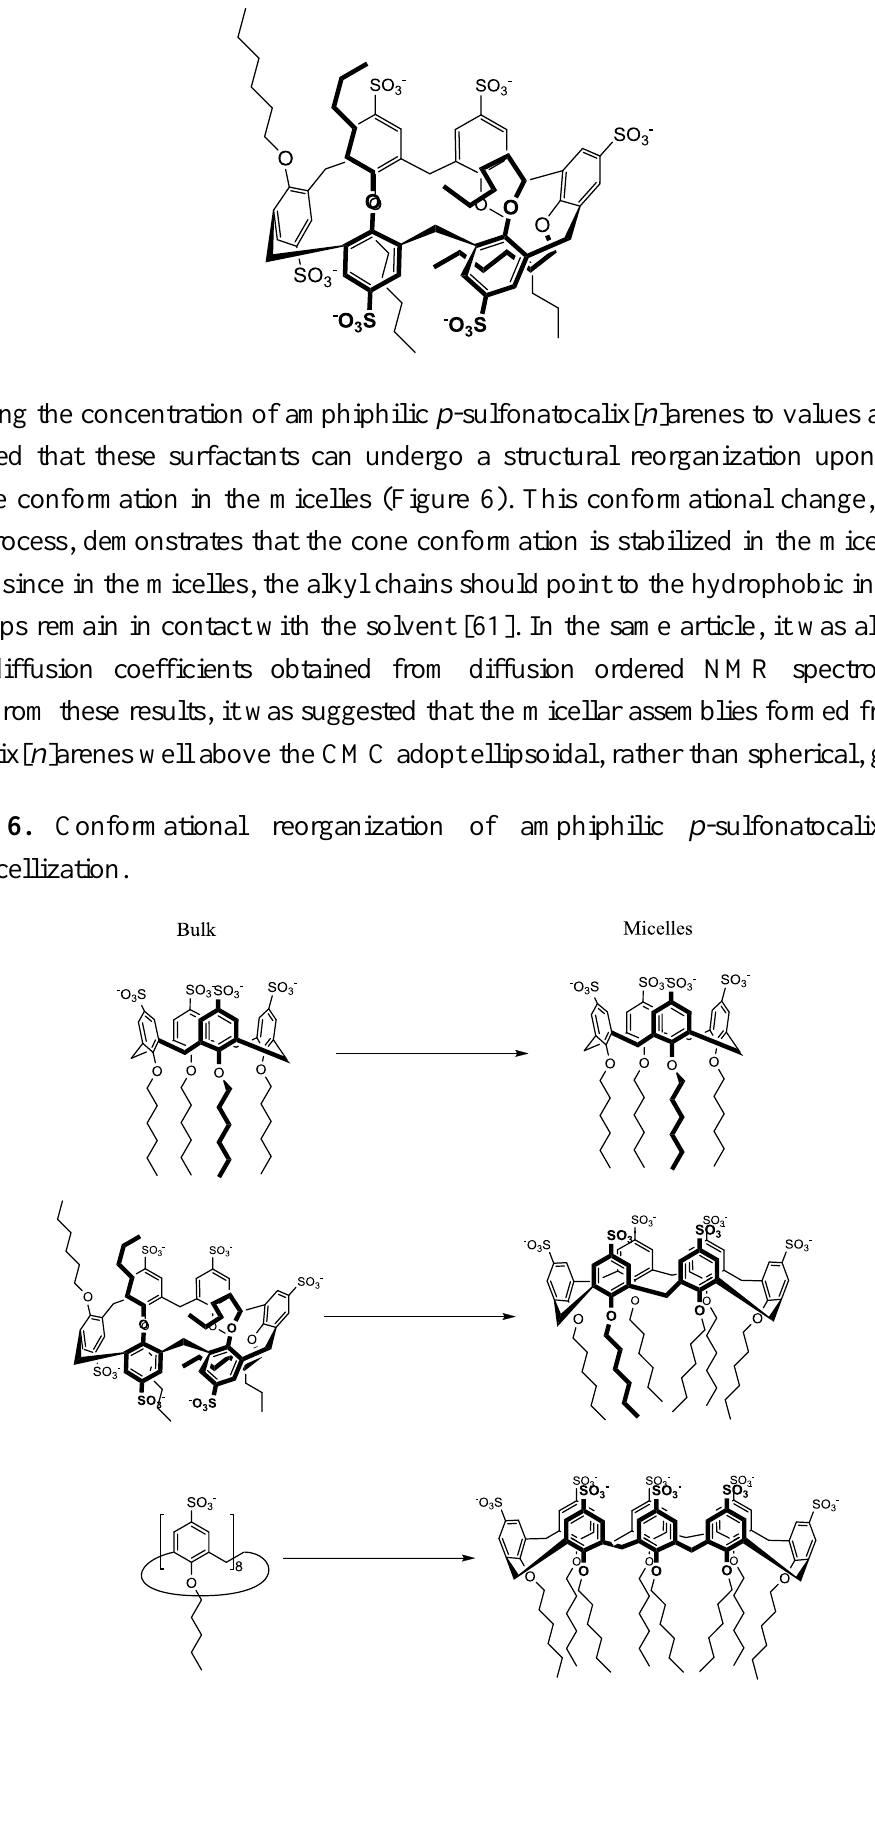
Figure 5. Pseudo 1,2,3-alternate conformation adopted by calix[6]arene 3d below the CMC.